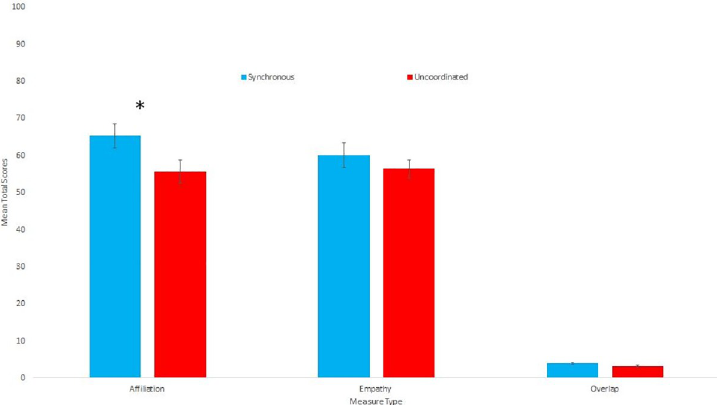
Fig 5. Means and standard errors for the Attitude change scores affiliation, empathy and overlap ratings towards the confederate in Study 2.